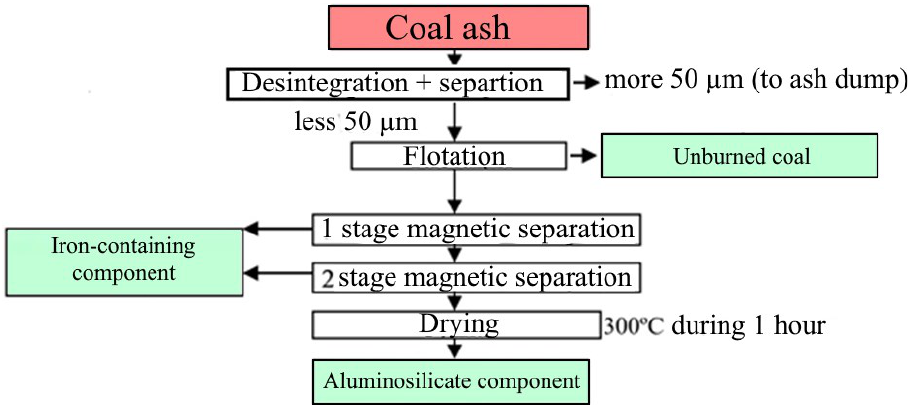
Figure 9. Developed technology of coal ash complex enrichment.